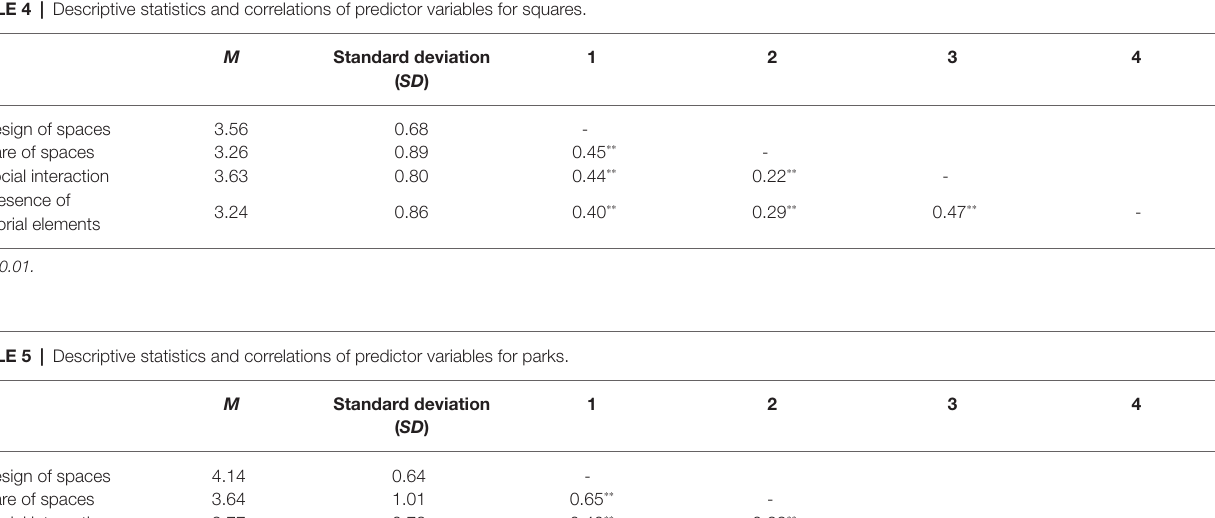
TABLE 4 | Descriptive statistics and correlations of predictor variables for